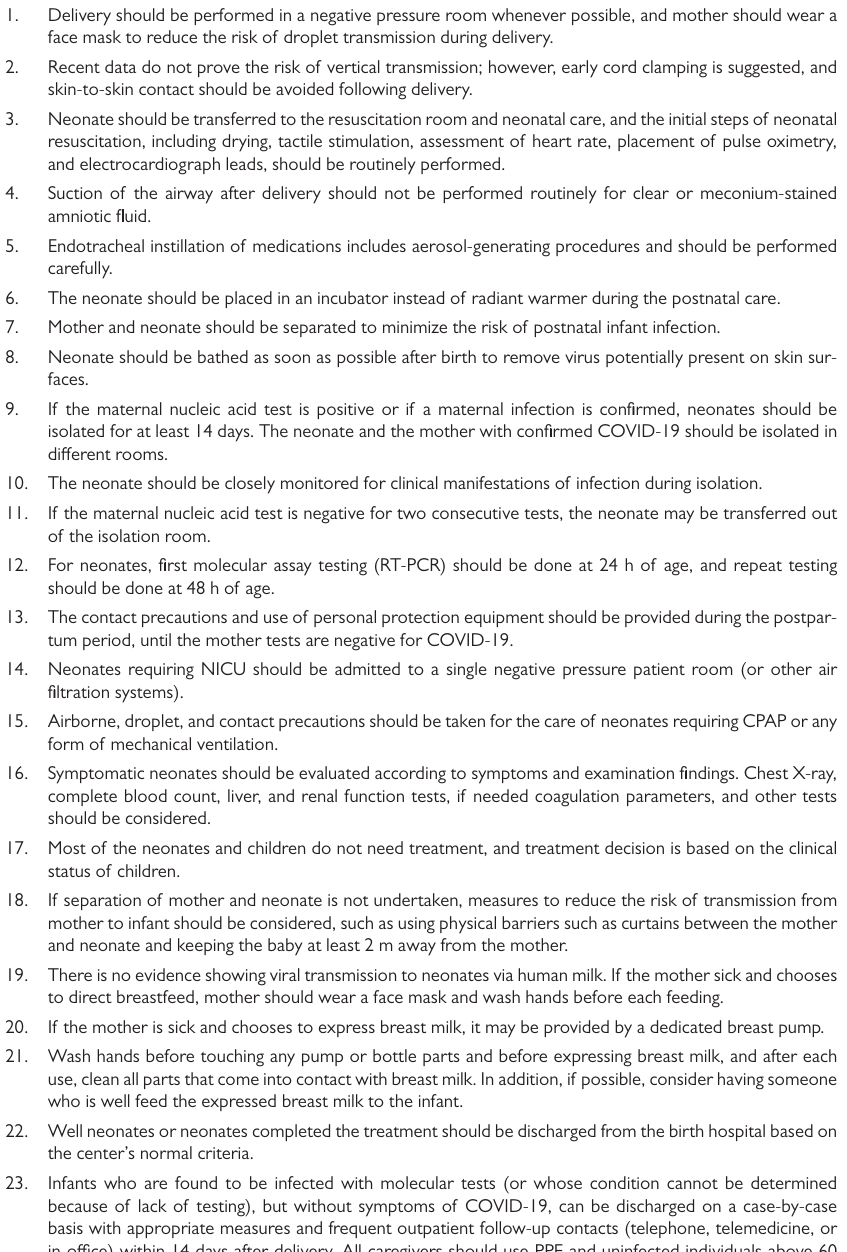
Table 2. Suggested management for neonates who were born from COVID-19 infected mothers